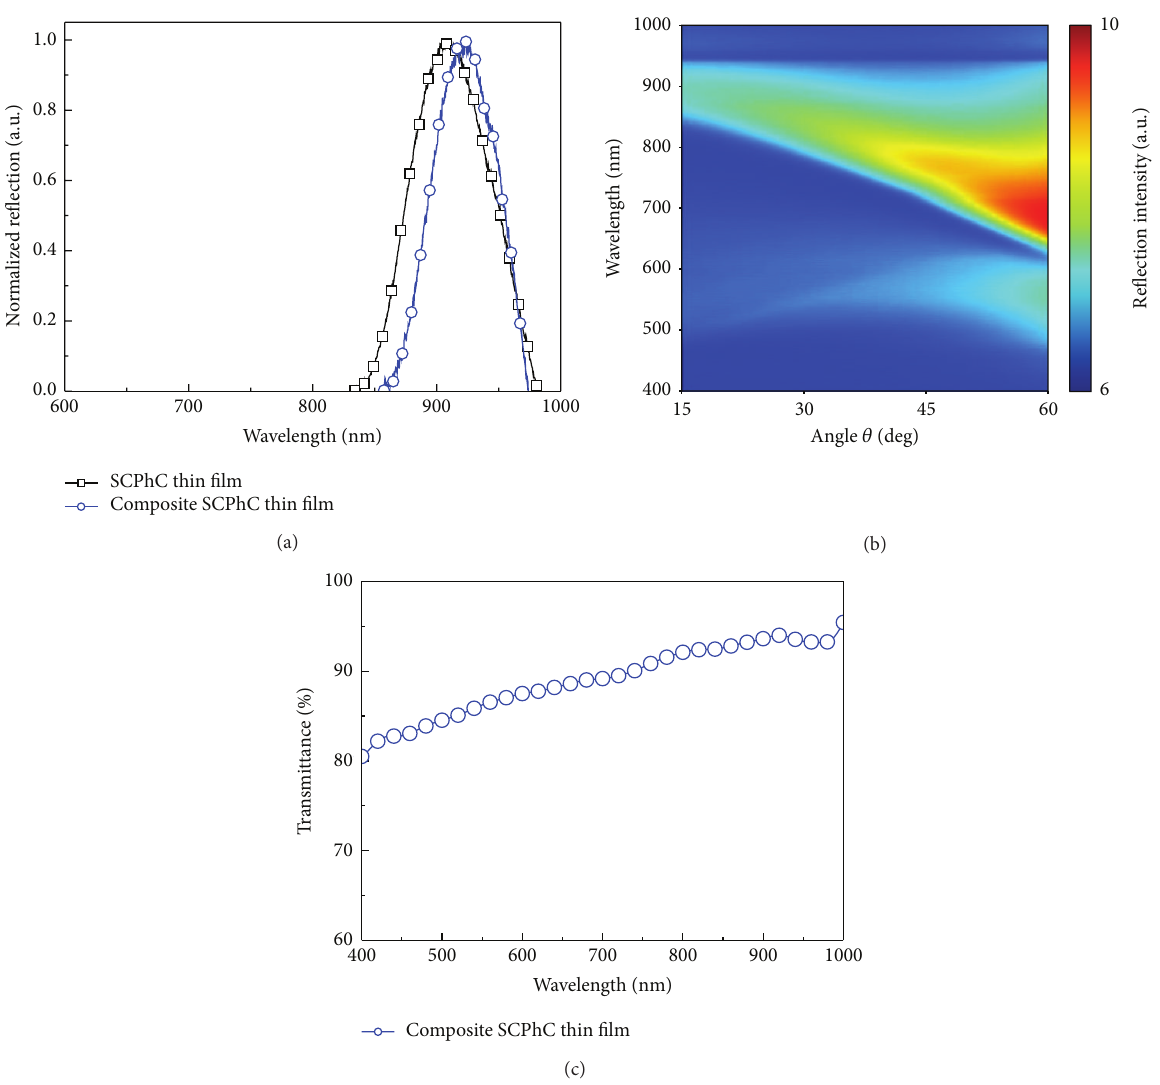
Figure 2: (a) Peak positions of the reflection spectra measured from the SCPhCs were 910 and 923 nm, respectively, before and after photocrosslinking was performed using a UV adhesive solution. (b) Unpolarized angular-resolved reflection measurements of c -SCPhC thin films. (c) Measured transmittance of the c -SCPhC thin